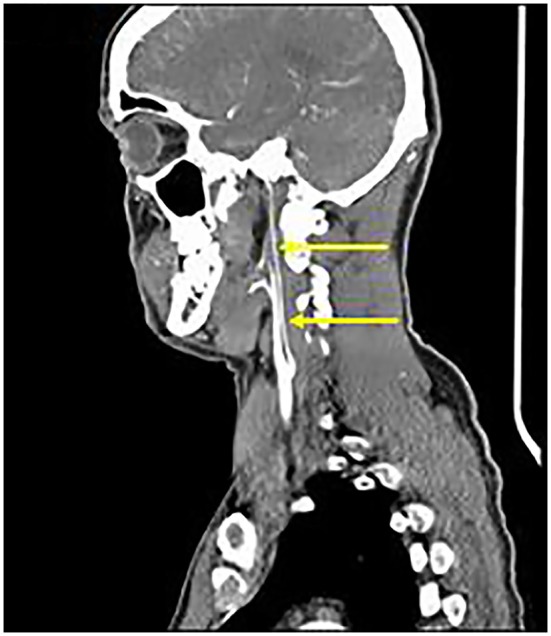
Extracranial CTA: Diffuse severe left ICA narrowing from 0.5 cm beyond the carotid bifurcation (arrows), consistent with “Alagille vasculopathy.”